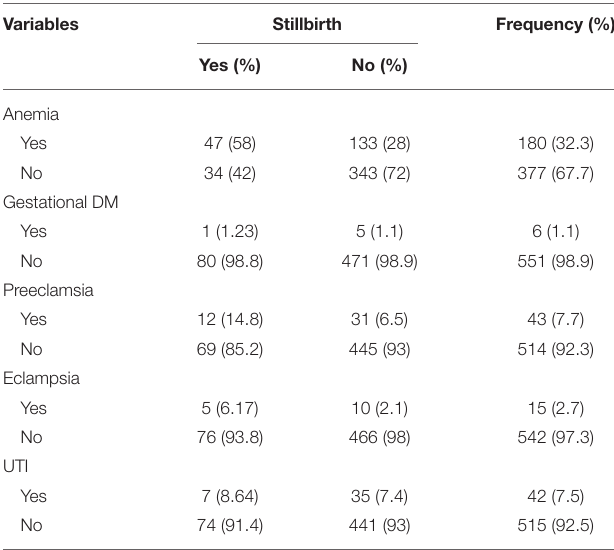
TABLE 3 | Medical condition of study participants ( n = 557), Hiwot Fana Specialized University Hospital, Harar, Eastern Ethiopia, 2018/2019.